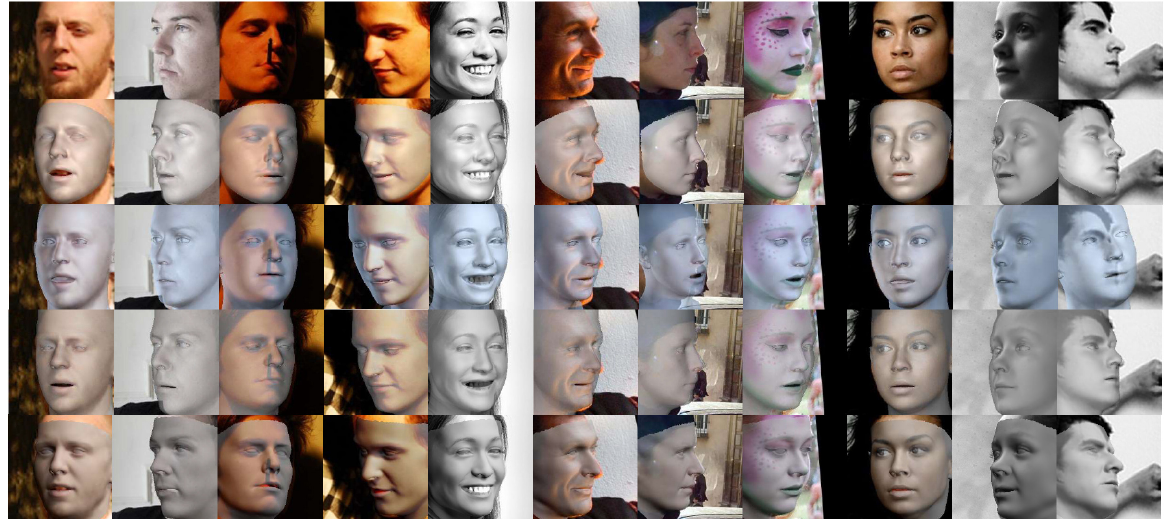
Fig. 8 Visualization results on ALFW2000 dataset. The first row: images from ALFW2000 dataset. The second row: the result of 3DDFA v2 [33]. The third row: the results of RingNet [9]. The forth row: the results of DECA [41]. The last row: the results of